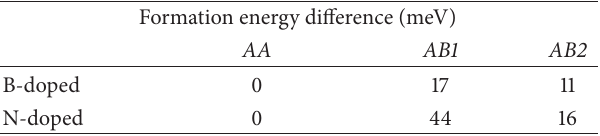
Table 1: Calculated formation energy difference between AA - and AB1 - ( AB2 -) stacked bilayer graphenes doped with B and N atoms. Reproduced with permission from [57], copyright 2015